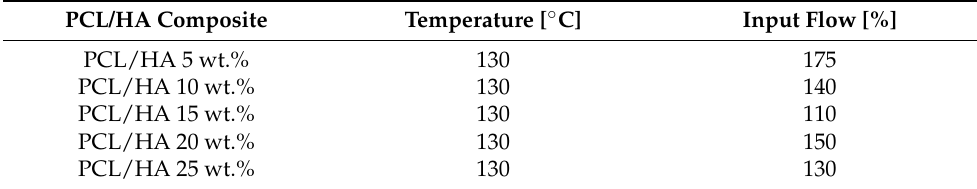
Table 1. 3D printing settings for each PCL/HA filament. PCL/HA Composite Temperature [ ◦